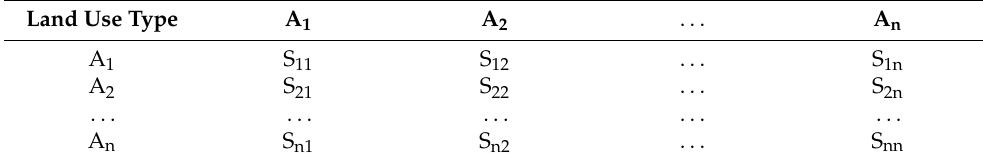
Table 2. A sample of the land-use change